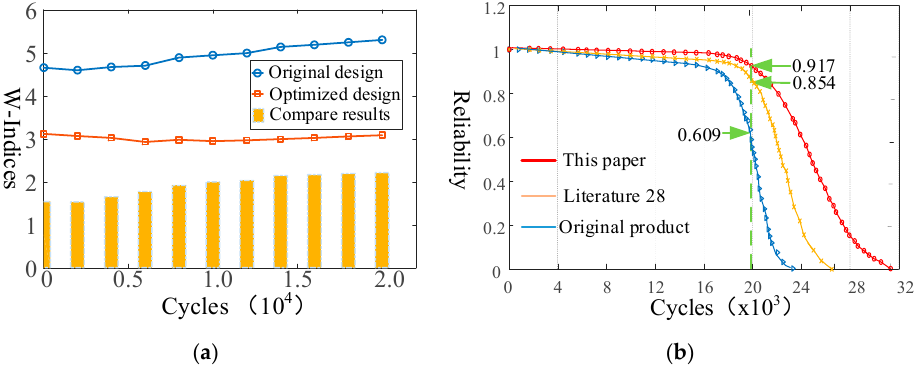
Figure 10. Comparison of optimization results: ( a ) W-Indices comparison ( b ) Reliability comparison of different method.